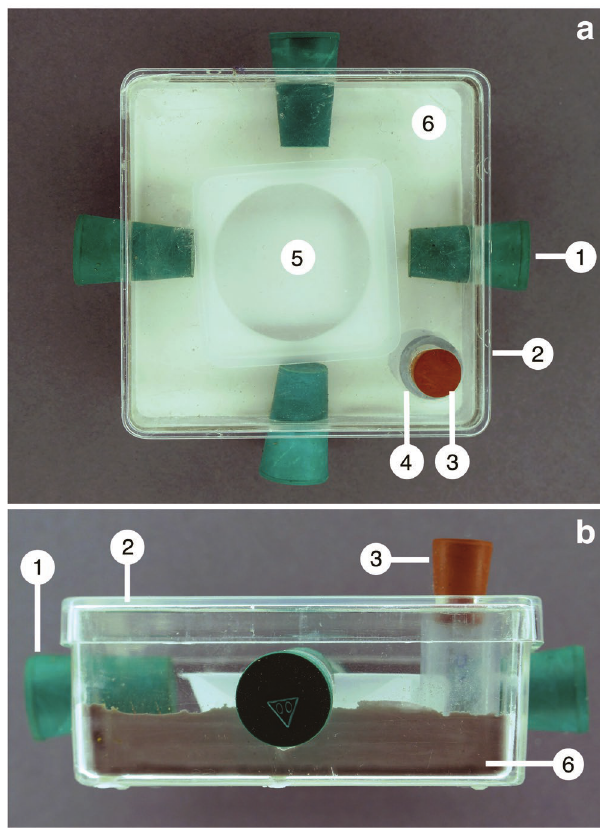
Fig 6. Garden nest box. a. Garden box as seen from above. b. Garden box as seen from the side. 1. Neoprene stopper No. 00; 2. Square polystyrene nest box; 3. Small, stopper No. 0000; 4. Short piece of Tygon tubing connecting the water well and the small hole in the lid, used to moisten the plaster without allowing the ants to escape. 5. Weigh boat used as a platform to separate the fungus garden from the plaster. 6. Dental stone (plaster) poured into the bottom of the box to a depth of ~0.5